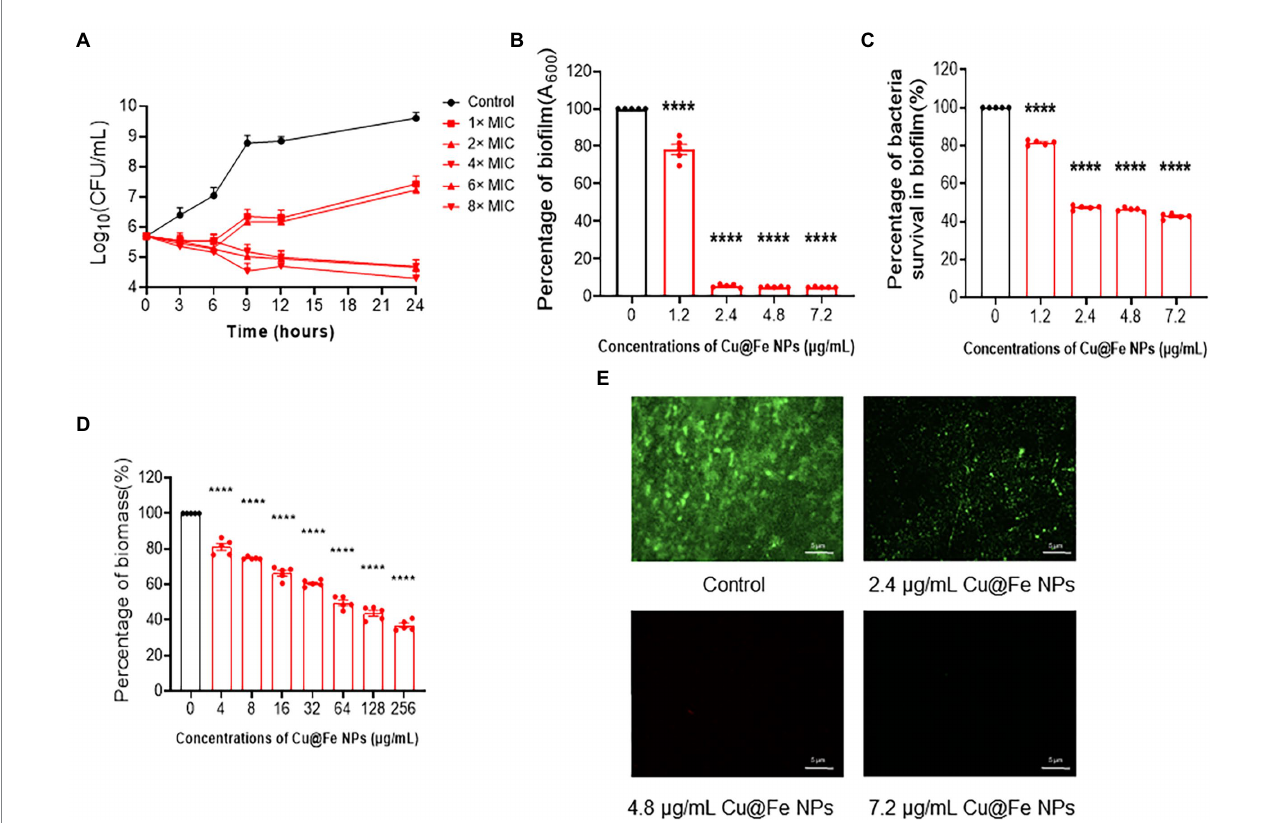
FIGURE 3 Cu@Fe NPs have good pharmacokinetic properties, and improve the sensitivity of drugs to MRSA by affecting the integrity of biofilms. (A) Time-dependent killing effect of different concentrations (0–8 μ g/mL) of Cu@Fe NPs on MRSA. (B , C) Changes in the mass of biofilms formed by MRSA and the percentage of viable bacteria in the biofilms treated with different concentrations (0–7.2 μ g/mL) of Cu@Fe NPs. (D) Damaging effect of different concentrations (0–256 μ g/mL) Cu@Fe NPs on the disruption of MRSA-formed biofilms. (E) SYTO9/PI fluorescence staining plots of MRSA biofilms treated with different concentrations (0–7.2 μ g/mL) of Cu@Fe NPs. Magnification, 200×. Scale bar, 5 μ m. (A–D) n = 5. Data are from three independent experiments. (B–D) One-way ANOVA with Dunnett’s multiple comparisons test. Data are expressed as mean ± SEM. **** p < 0.0001 versus Control